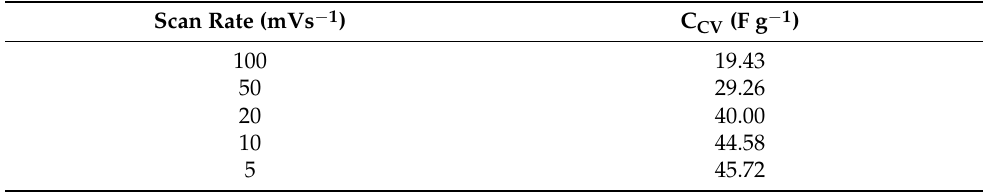
Table 5. Capacitance from CV